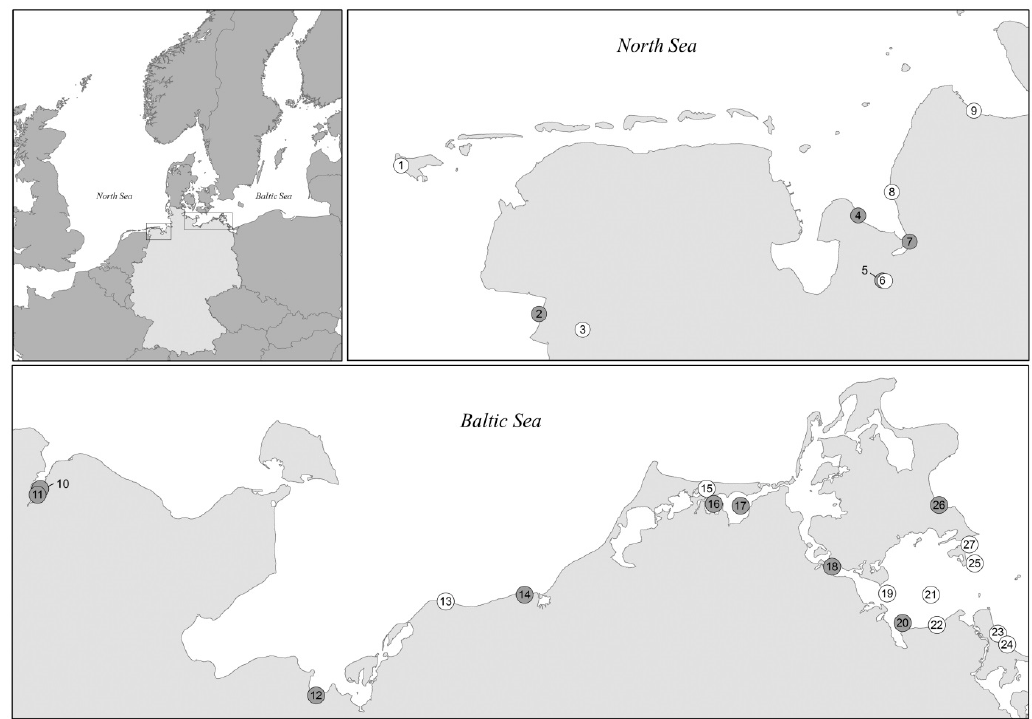
Figure 1. Geographical location of sampling sites along the North Sea and Baltic Sea coastline. For detailed information on sampling sites, refer to Supplementary Table S1. Grey dots indicate sampling sites at which strains of MLST cluster II have been isolated at least once. White dots represent sampling sites at which all isolated strains belonged to MLST cluster I. Sampling Sites 3, 5 and 6 are located in estuaries, rivers are not indicated in the